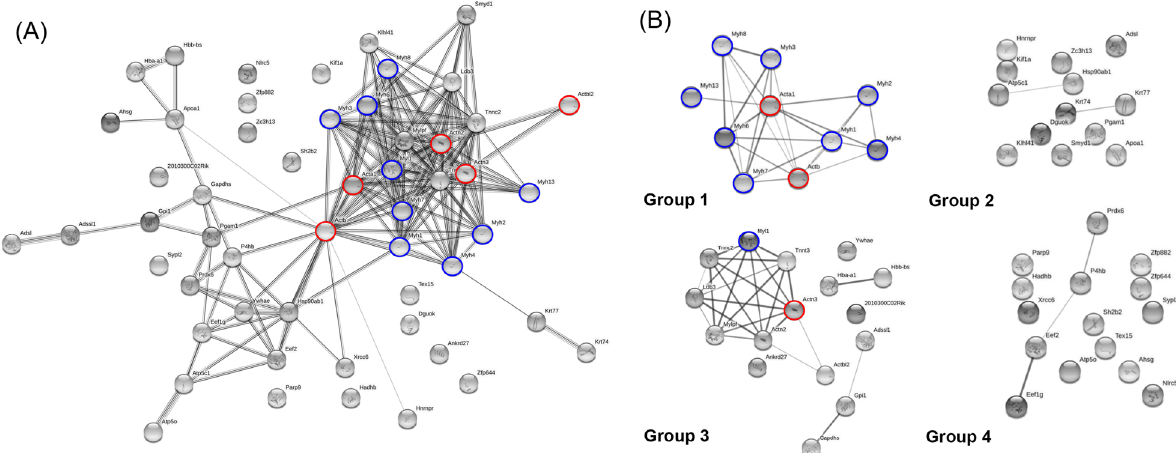
Fig. 3 Protein network analysis of whole mouse soleus muscle proteomes. Protein network was constructed using STRING database (https:// string‑ db. org). A Full view of protein–protein interaction network. B Main protein–protein network (group 1) and satellite networks (group 2–4). Red and blue circle indicates actin and myosin isoforms,